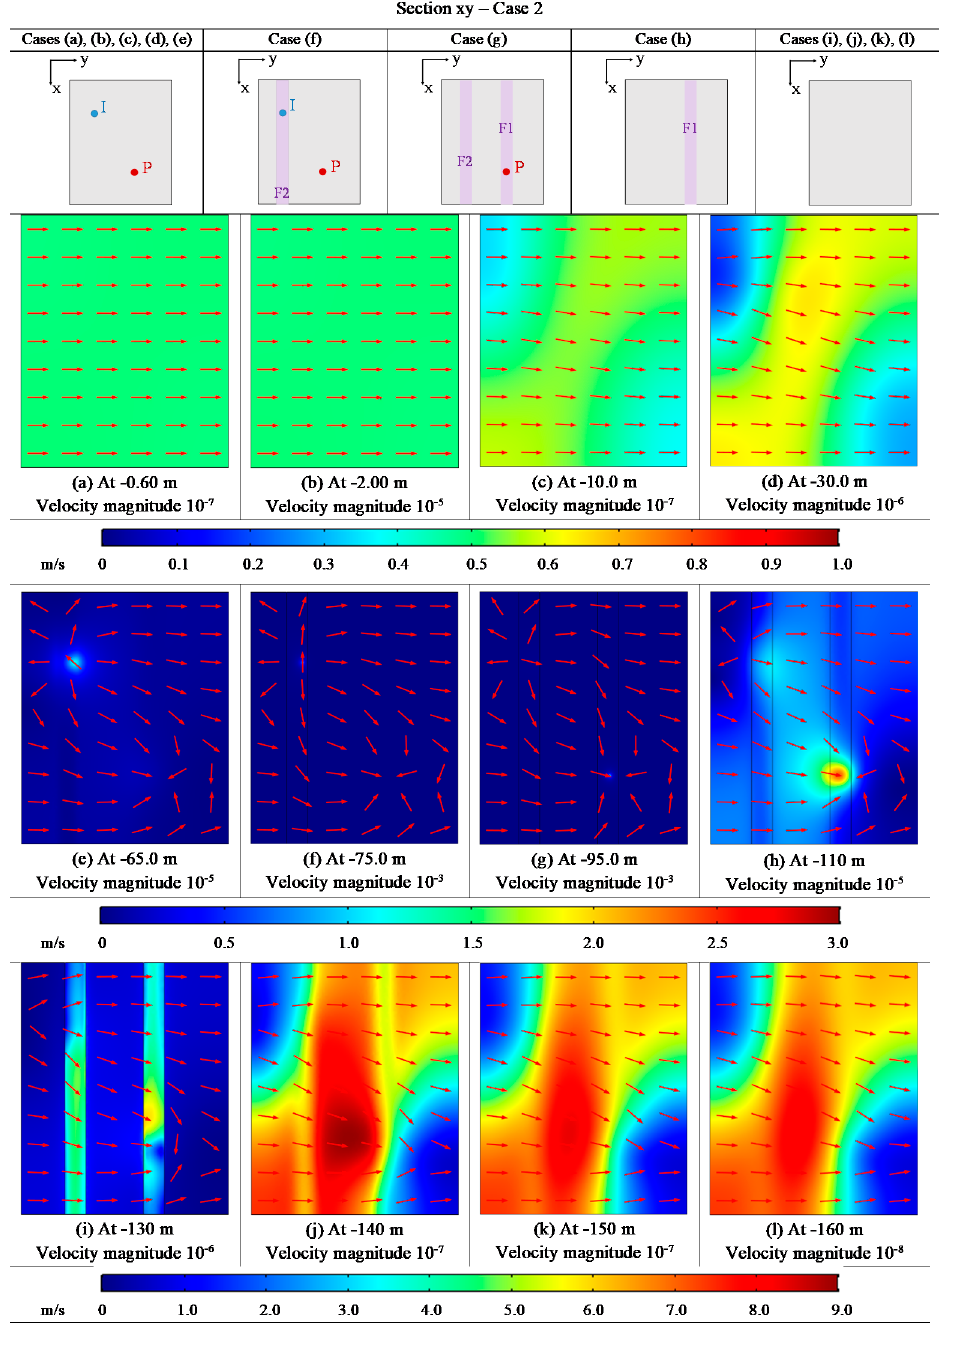
Figure 14. Darcy velocity field at different depths for Case 2 (two faults).